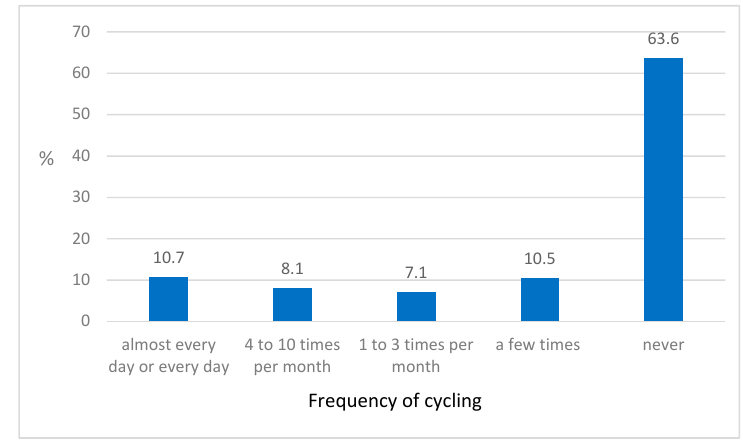
Figure 5. Frequency of cycling among students of the University of Maribor.